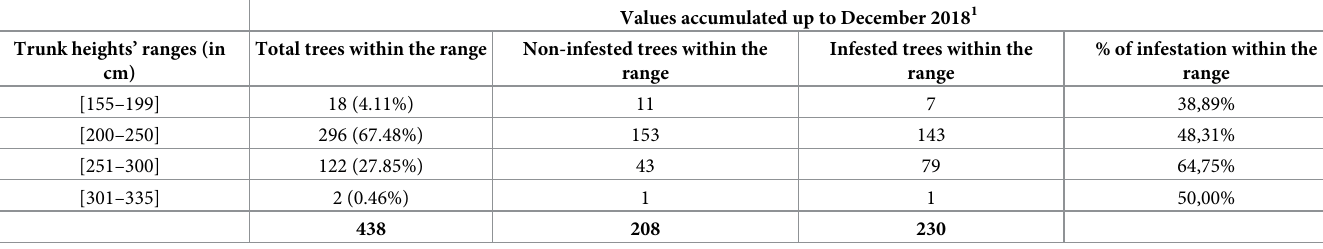
Values accumulated up to December 2018 1